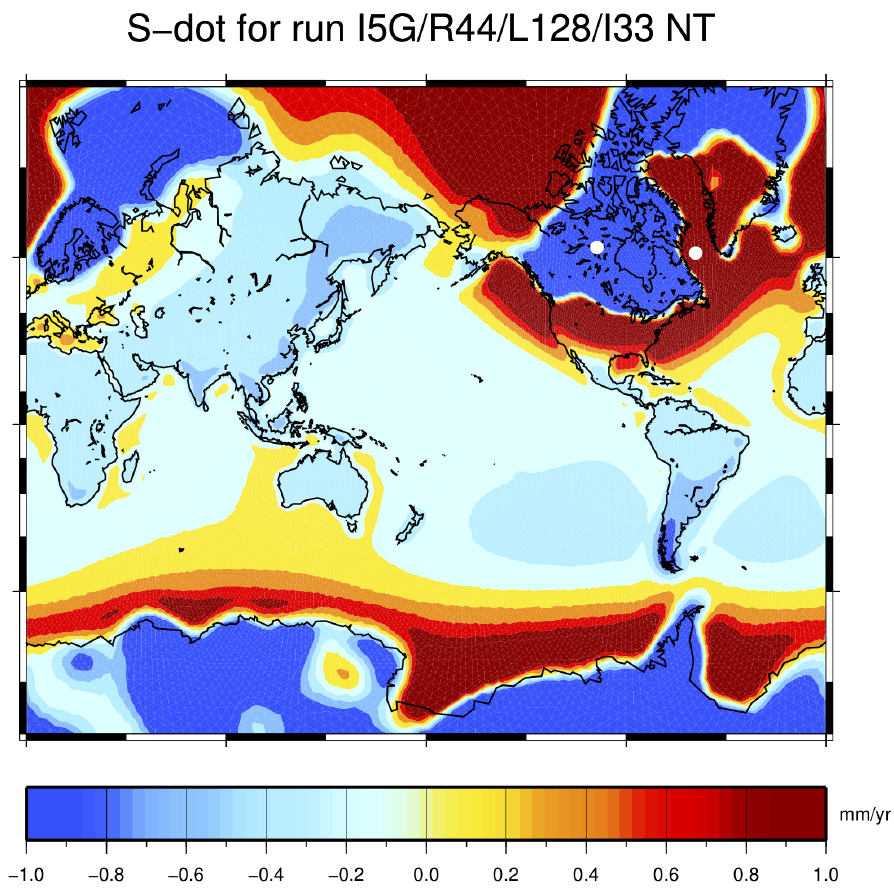
Figure 3. GIA fingerprint for ˙ , the present-day rate of relative sea-level change, obtained by S implementing model ICE-5G (VM2) in SELEN 4 . To better visualize the regional variations, the palette is limited to the range of 1 mm year − 1 . The largest rates, marked by white dots, are associated ± with the isostatic disequilibrium still caused by the disintegration of the Laurentide ice sheet complex, + 5.3 mm year − 1 , respectively. The most significant regional variability, with ˙ 17.9 and ˙ S ∼ − S ∼ measured as the density of local maxima and minima of ˙ in this map, is found to within 1500 km S ∼ from the continental